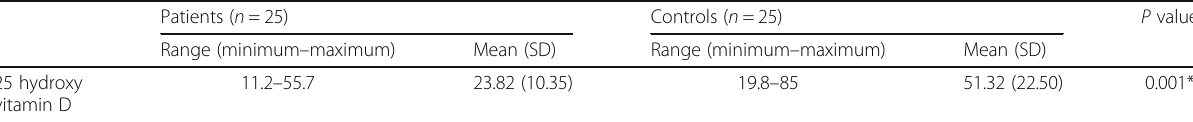
Table 4 Serum 25 hydroxy vitamin D level in patients and controls